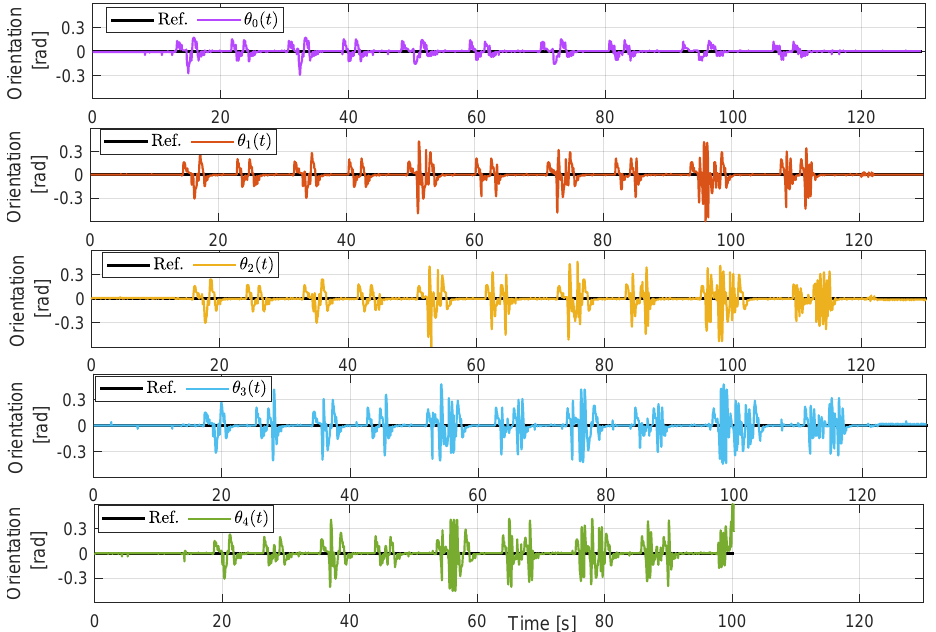
Figure 10. Angle tracking using the non-cooperative strategy.